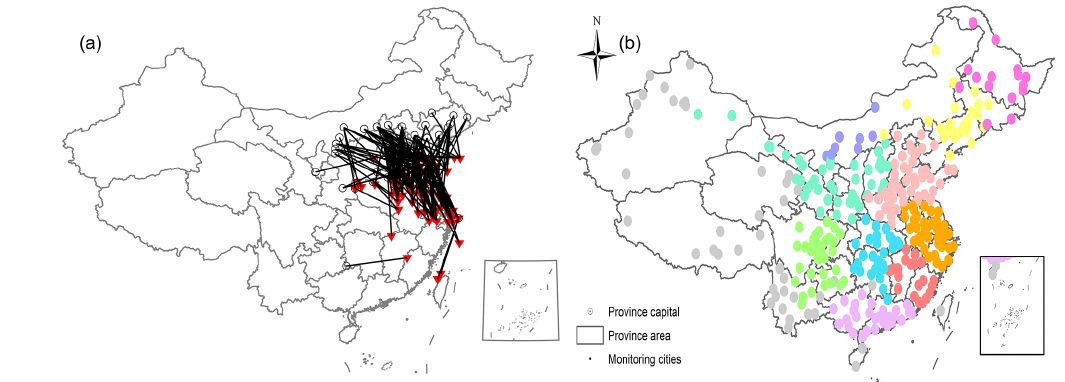
Figure 7. (a) Map of PM 2 . 5 transport links among the monitoring cities in China. (b) The cluster regions of PM 2 . 5 concentrations. Different colors represent different communities.